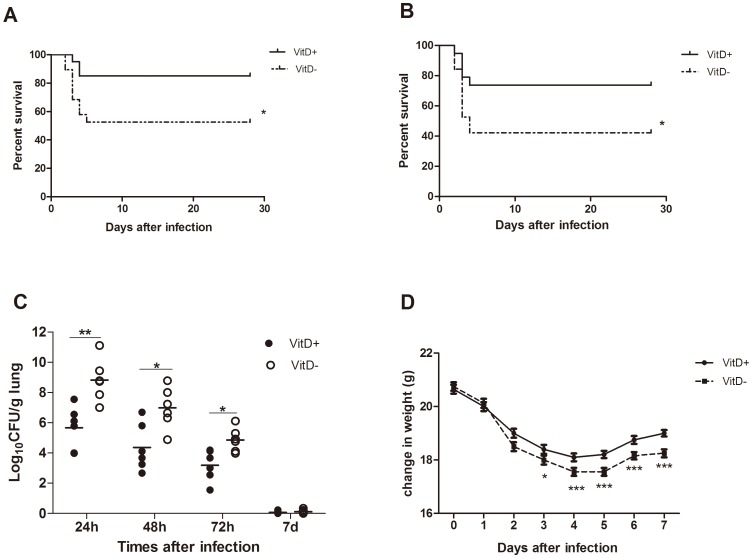
Enhanced susceptibility of VitD- mice after challenge with A. fumigatus.VitD+ and VitD- mice were challenged intratracheally with 5×107 (A), or 7×107 (B) A. fumigatus conidia in a volume of 50 µl. Survival was monitored for 28 days (n = 7 per group) and expressed as percentage of survival. This figure illustrates cumulative results from three independent studies per inoculum dose. The difference between survival rates was significant at p<0.05 (Log-rank test and Wilcoxon test). C. Fungal growth in the lungs of VitD+ and VitD- mice challenged intratracheally with 2×107
A. fumigatus conidia. Mice were sacrificed at the indicated times p.i., and serial dilutions of tissue homogenates were plated for CFU determination. Results are expressed as log10 of CFU average values determined in triplicate of three independent experiments (three for each dilution using two animals of each group). Each data point represents one mouse. Differences in CFU between VitD+ and VitD- mice were significant at p<0.05(*) and p<0.01(**) (Mann–Whitney U test). D. Infection-induced weight changes in mice were determined daily after intratracheal challenge with 2×107
A. fumigatus conidia. Values repersent means±SE (n = 12). p<0.001(***), p<0.01(**), p<0.05(*) (paired Student's t test).